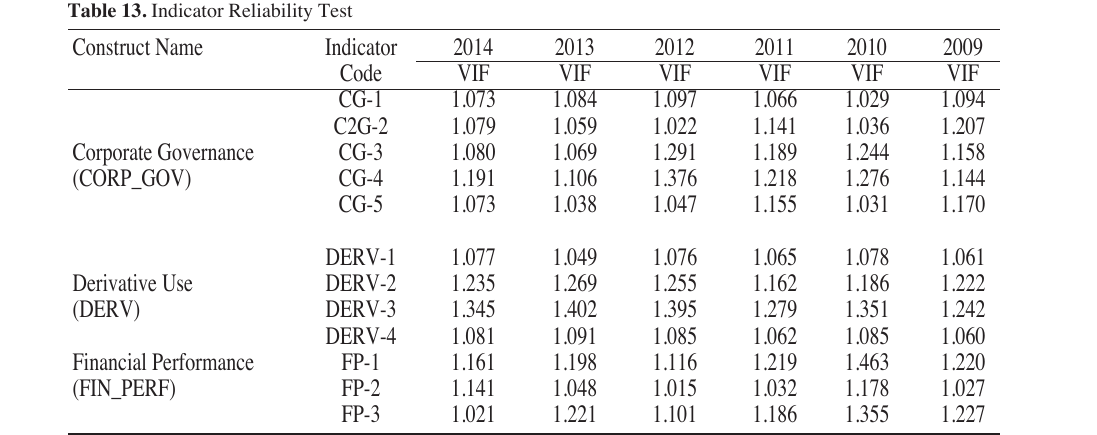
Table 13. Indicator Reliability Test